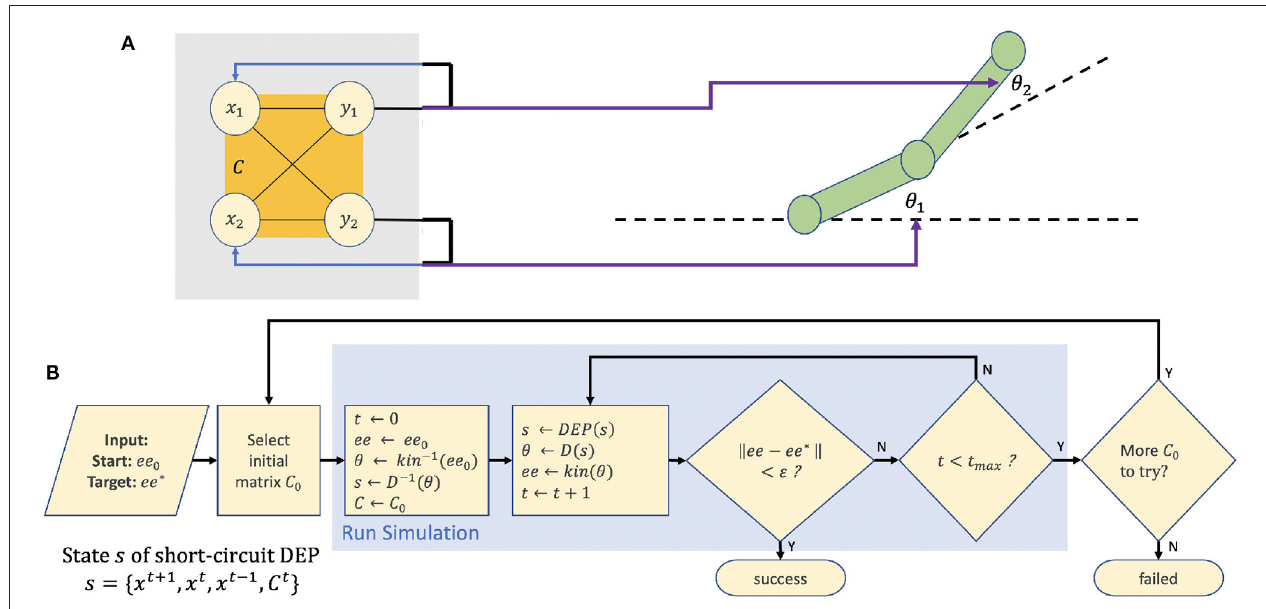
FIGURE 3 | (A) The experimental setup. A “short-circuit” DEP controller drives a 2DOF robotic arm in an open loop fashion. (B) A flowchart of the search algorithm for obtaining a value for C 0 that reaches a desired target ee ∗ from starting position ee 0 .